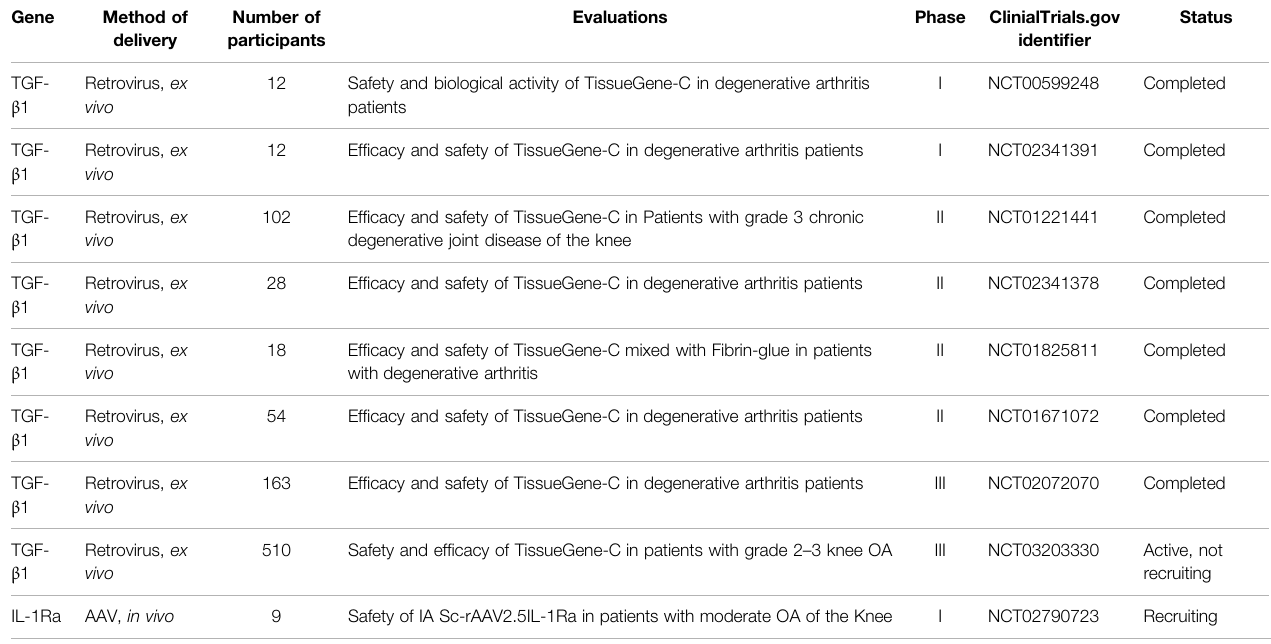
TABLE 3 | Registered clinical trials on the gene therapy of OA. Gene Method of Number of delivery